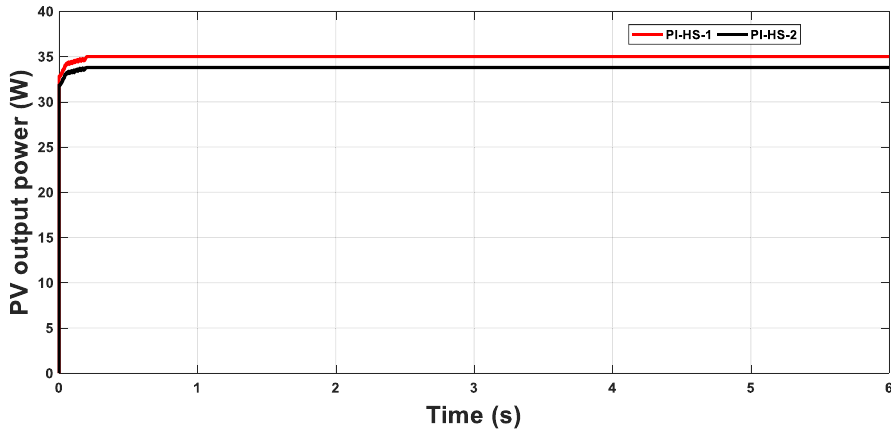
Figure 7. MPPT with fixed and variable PI-HS.